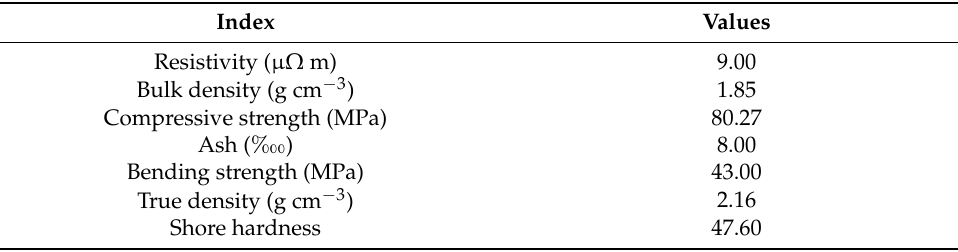
Table 1. The quality inspection report of the graphite rod.